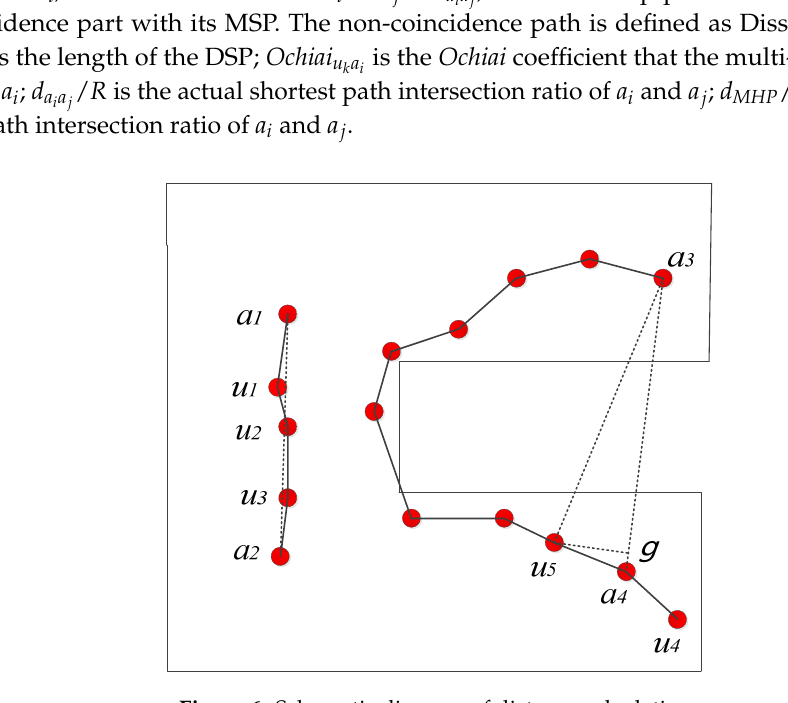
Figure 6. Schematic diagram of distance calculation.